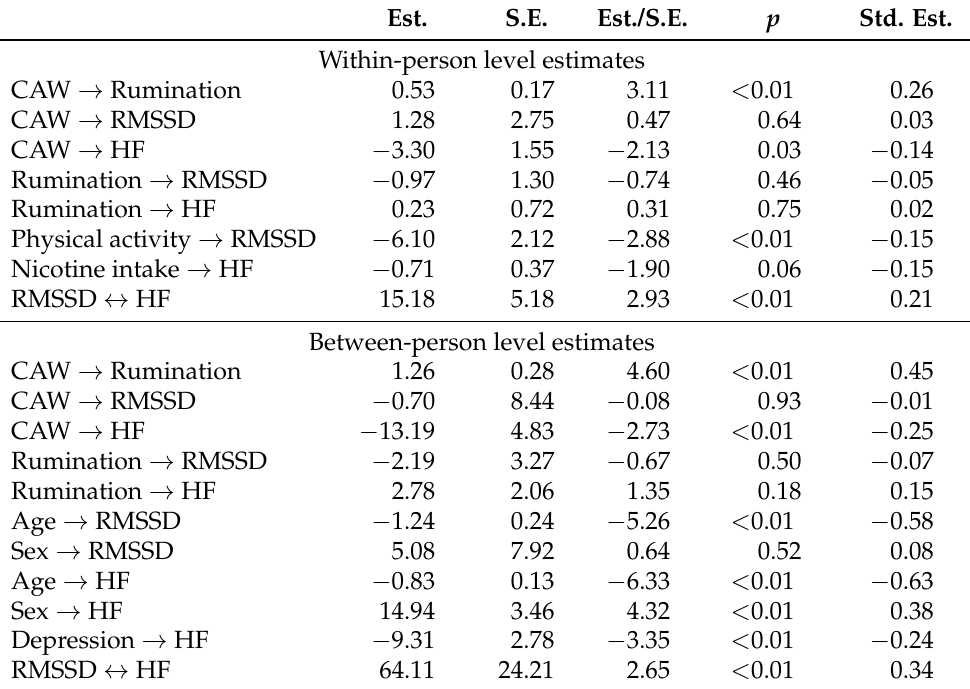
Table 2. Standardized and unstandardized within- and between-person level estimates. Est. S.E. Est./S.E. p Std. Est. Within-person level estimates CAW → Rumination 0.53